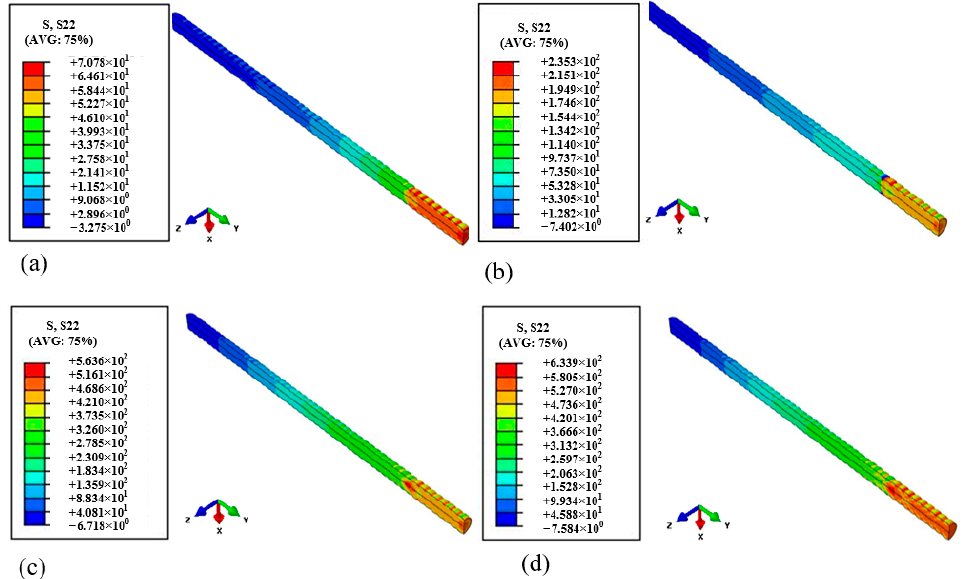
Figure 12. Stress nephogram of GFRP bolt with anchor length of 420 mm: ( a ) F = 40 kN, ( b ) F = 80 kN, ( c ) F = 160 kN, ( d ) F = 240 kN.